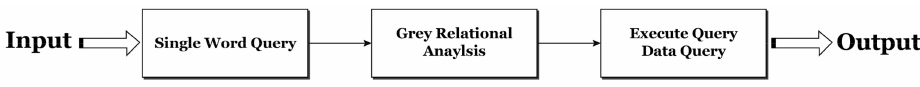
Figure 8. The relational operation model of program development.